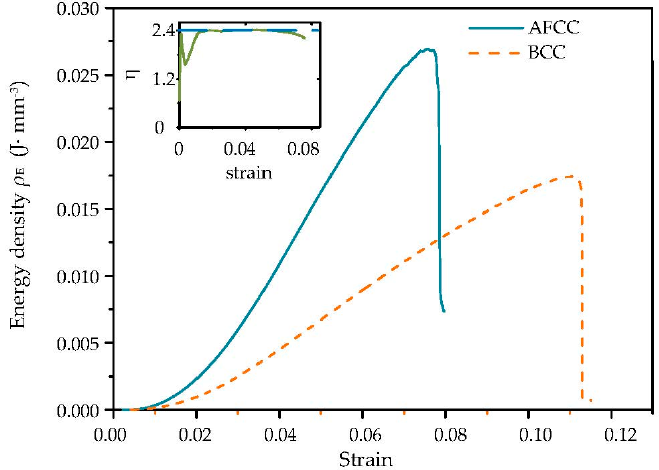
Figure 14. Energy analysis curves of AFCC and BCC lattice structures; the inset shows the ratio of the AFCC and BCC structures energy